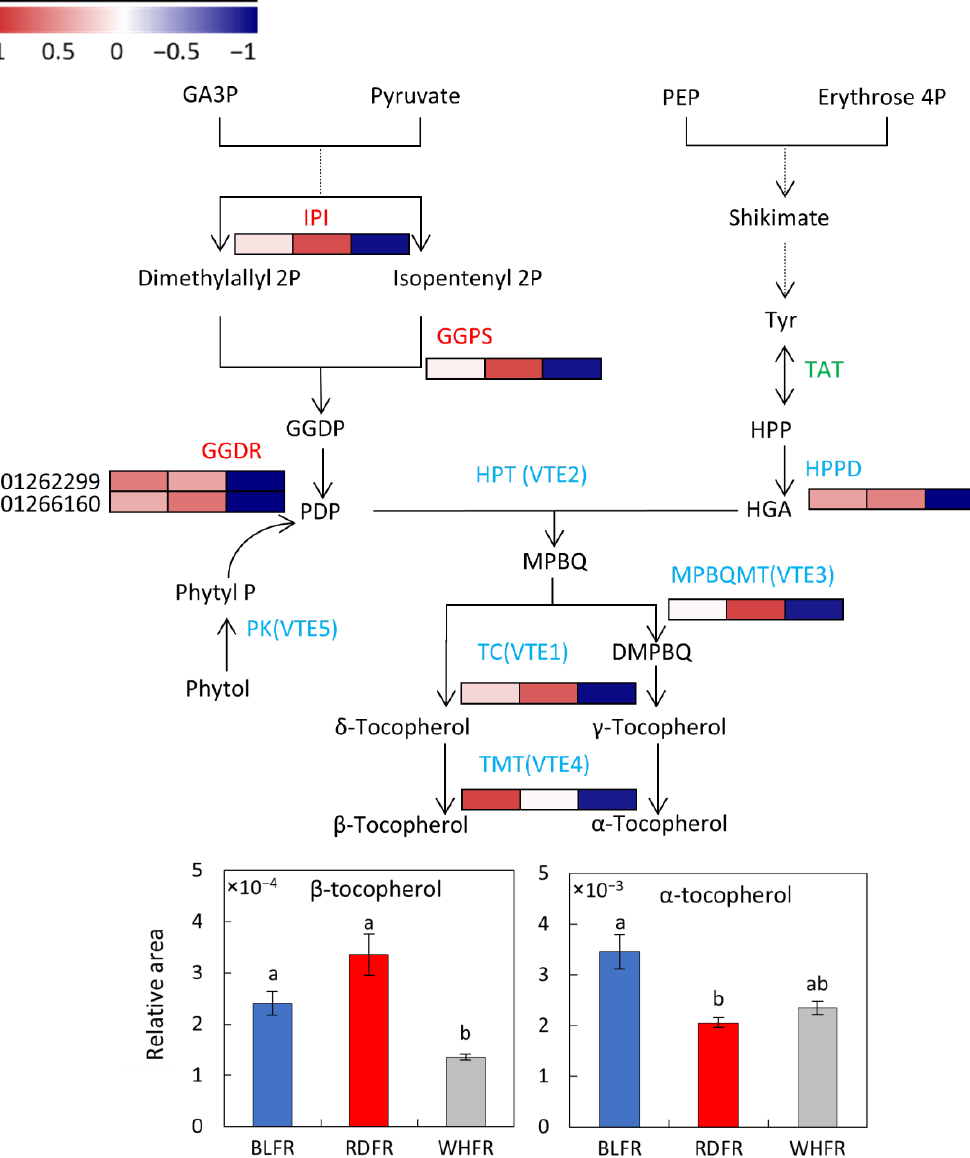
Figure 11. Transcriptomic profile and metabolic profiles of the tocopherol biosynthetic pathway, including methyl erythritol (MEP) pathway (red), Shikimate (SK) pathway (green), and vitamin E core pathway (blue). Significant differences were found in the transcription level of IPI , GGPS , HPPD , and VTE3 in RDFR vs. WHFR, VTE4 in BLFR vs. WHFR, and VTE1, GGDR (101262299; >2 FC) and GGDR (101266160) in WHFR vs. other treatments. Red and blue rectangles indicate higher and lower levels, respectively, than the mean of all treatments. Values indicate the z-score in the legend. β -tocopherol (B) and α -tocopherol (C) concentrations in fruits treated with different light treatments. Values indicate the mean ± SE ( n = 3). Different letters indicate significant differences at p < 0.05 by an independent t -test. BLFR, RDFR, and WHFR refer to blue, red, and white light-treated fruits, respectively.